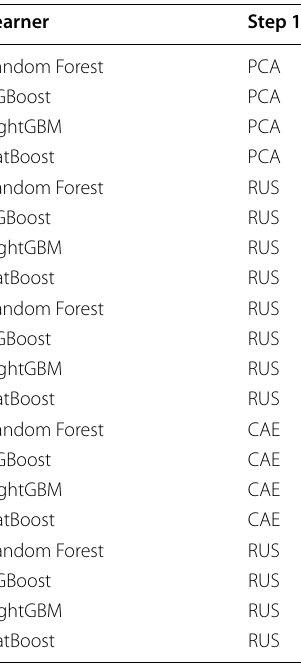
Table 3 Performance scores for RUS (1:1